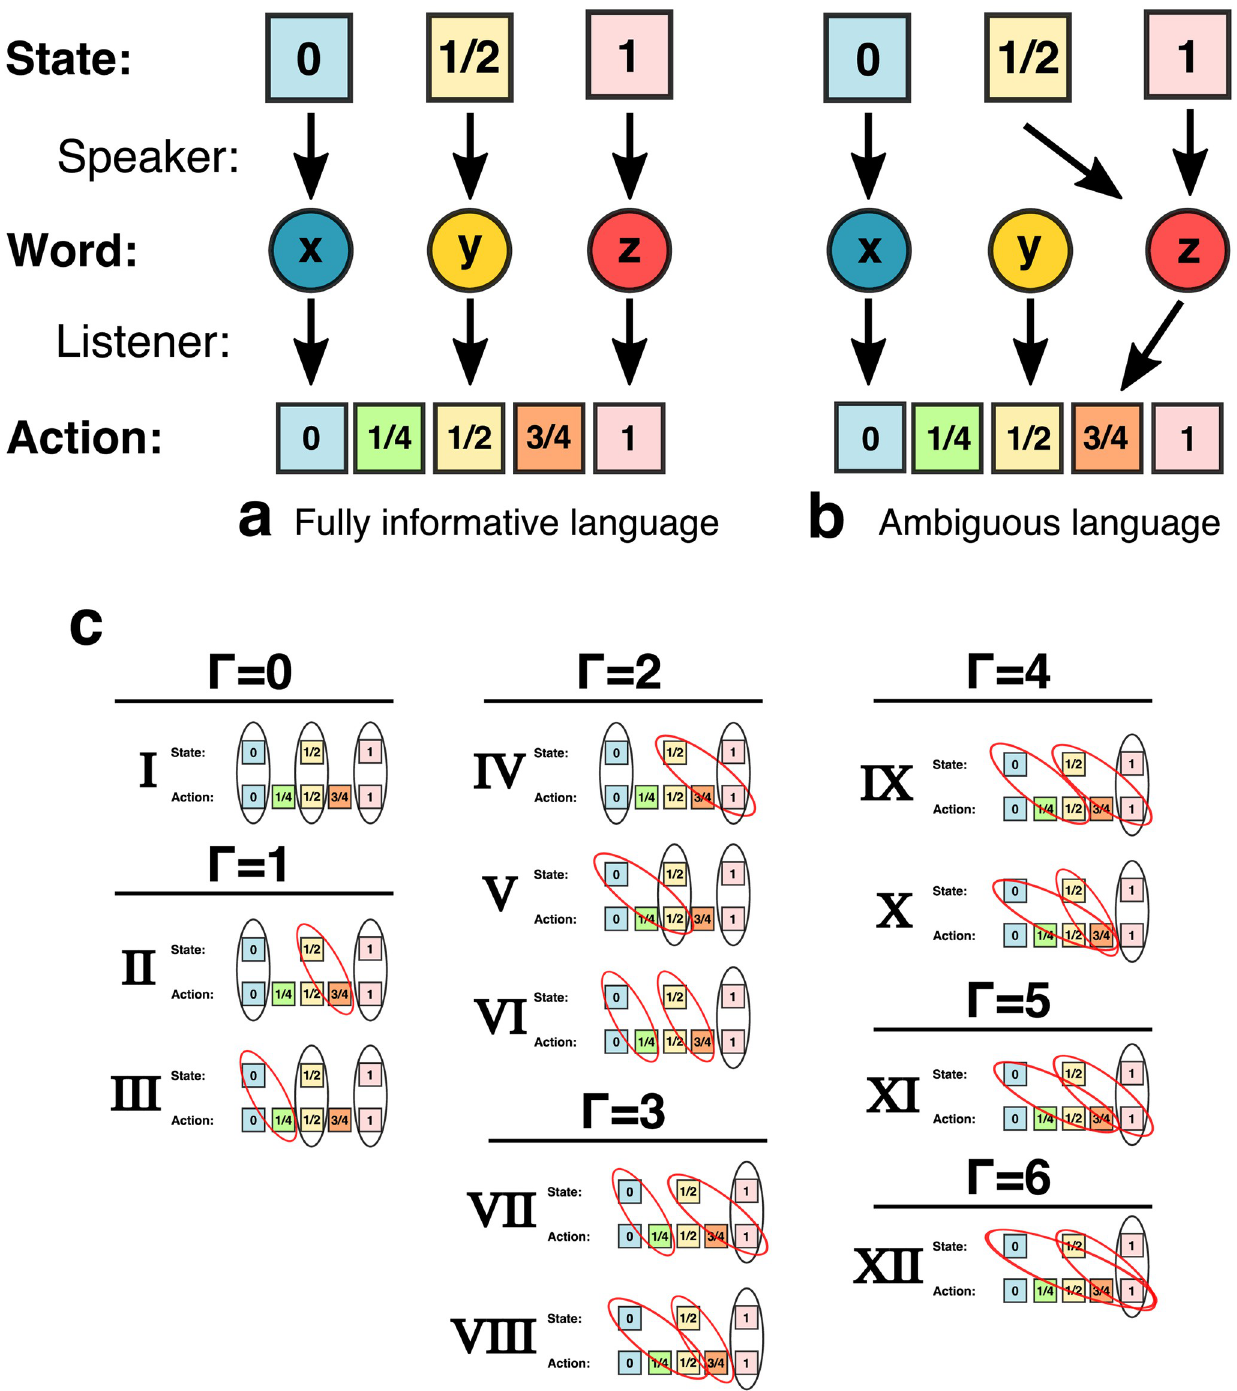
Fig 1. A representation of how misalignment of interests could lead to linguistic change. (a) : A fully informative language. The speaker uses a different word for each object, allowing the listener to perfectly translate each word back into the object it came from, and to act optimally in response—that is, to choose an action value equal to the object value. (b) : An ambiguous language, using the same polysemic word for objects 1/2 and 1. The polysemy confuses the listener, who cannot translate it accurately, and therefore cannot identify the object when it is 1/2 or 1. (c) : For the states and actions shown here, there is one configuration of the speaker’s preferred action per state, a � ð s Þ that is aligned with the listener’s preferred action per state (game I ), as well as eleven i S possible scenarios where a � ð s Þ > s for at least one state; that is, the speaker would prefer an action greater than the listener would prefer. The degree of i i S misalignment for the whole game, Γ , can be graded as the sum of misalignments per state, times the frequency of that state. Here we additionally multiply Γ by 12, simply so the net misalignment is always a whole number. These games are shown in larger scale in Fig B in S1 File. https://doi.org/10.1371/journal.pcbi.1010872.g001 PLOS Computational Biology | https://doi.org/10.1371/journal.pcbi.1010872 February23, 2023 5 /